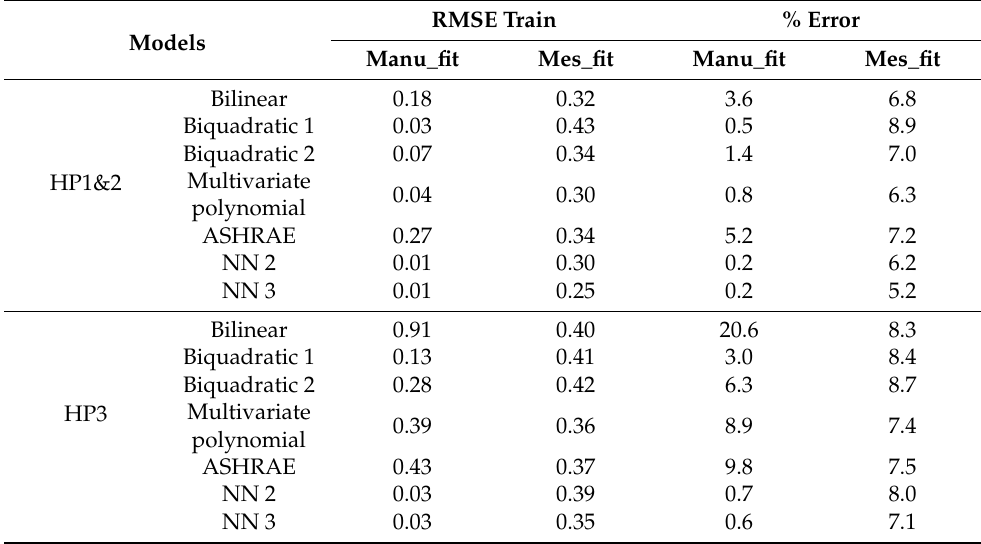
Table 4. Training error of HP1&2 and HP3